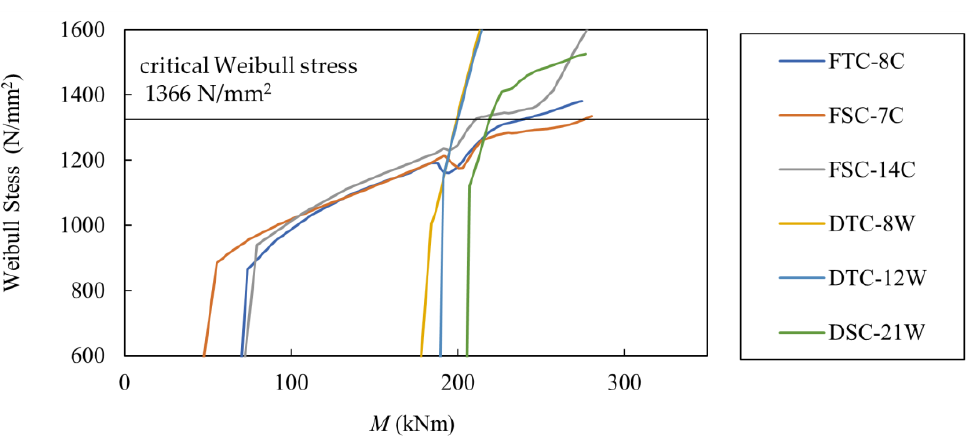
Table 5. Failure moment prediction results.